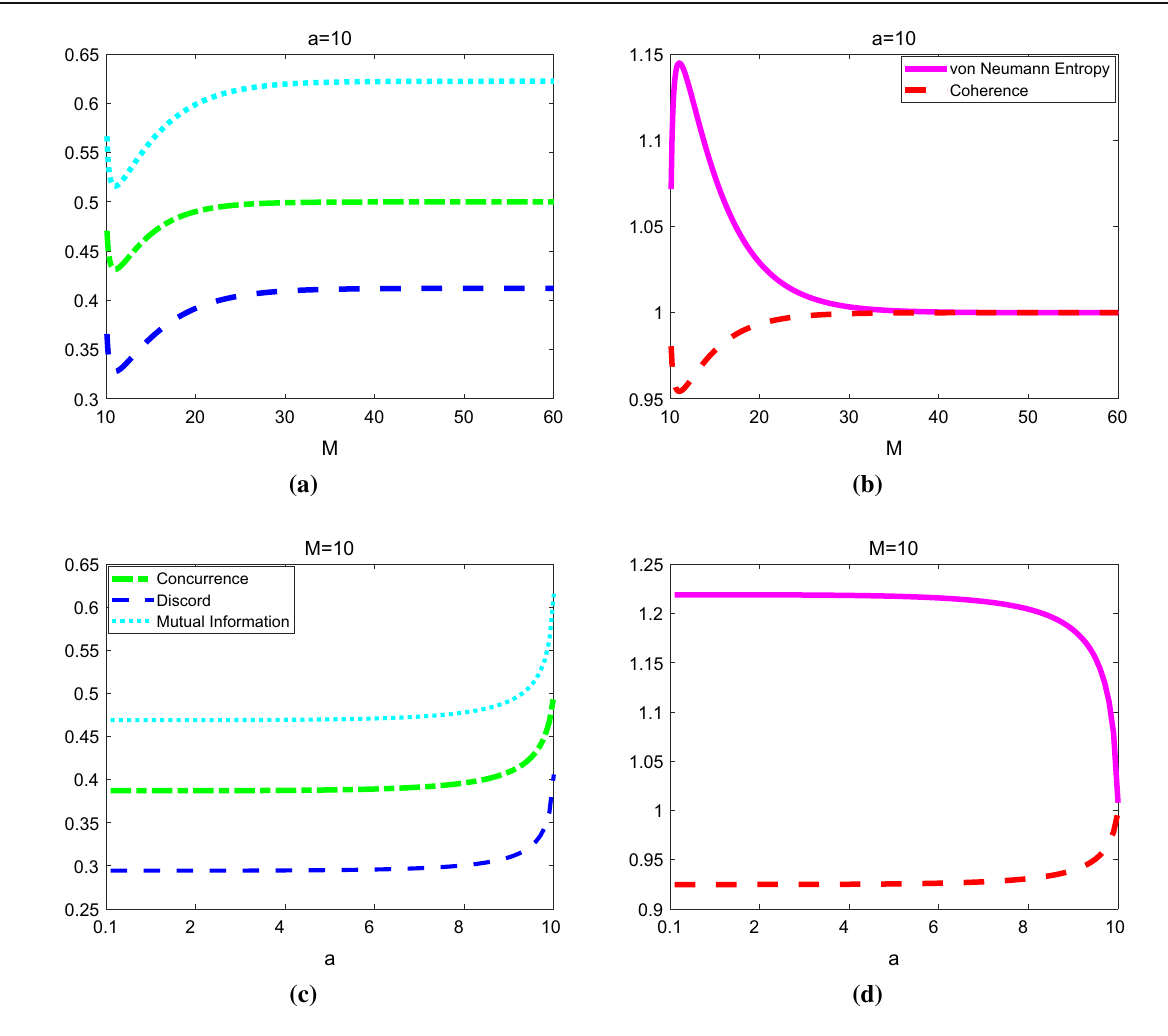
Fig. 2 Quantum correlations at equilibrium state vs. mass or angular momentum per mass. The angular momentum per mass a is set up as 10, and the mass is changed from 10 in a , b . The mass a is set up as